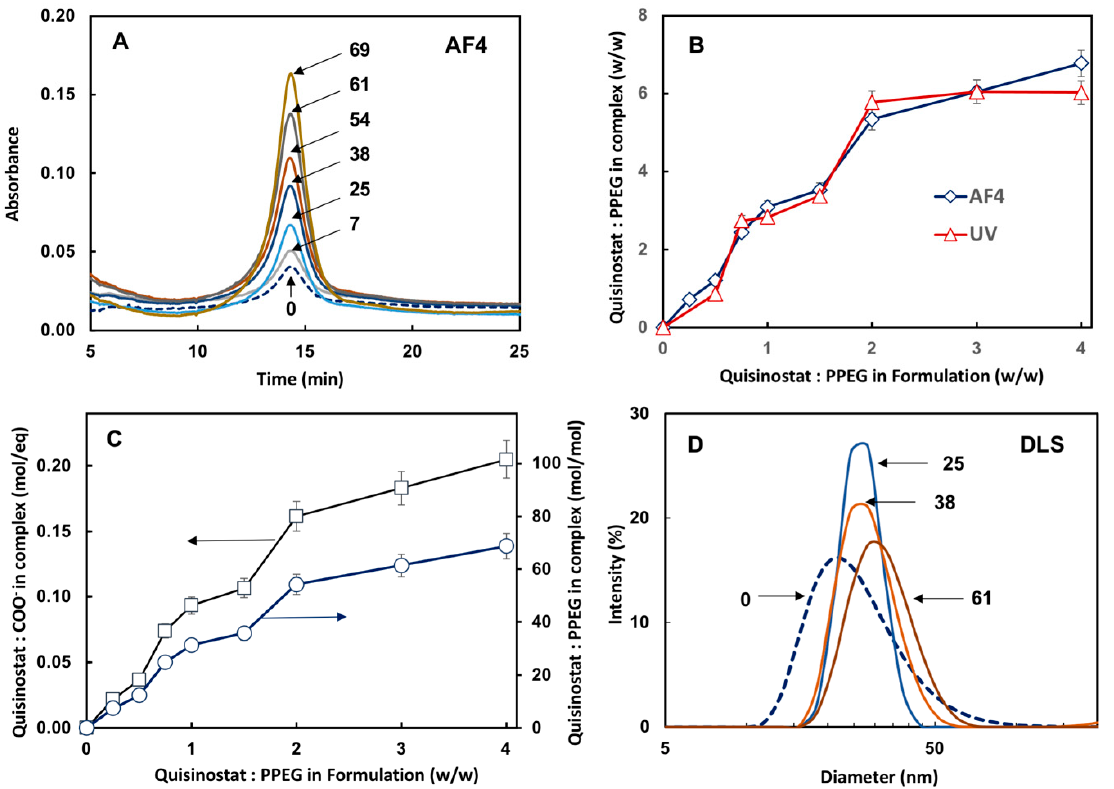
Figure 2. ( A ) AF4 fractograms of PPEG and quisinostat-PPEG complexes showing growing macromolecular peak area as the content of drug increases; ( B ) comparison of polymer composition as measured by AF4 and UV-spectroscopy; ( C ) composition of complex expressed as degree of neutralization of anionic group on PEPG and drug-to-polymer molar ratio as a function of quisinostat-to-PPEG ratio in the original formulation; ( D ) DLS profiles of quisinostat-PPEG complexes (numbers in panels ( A , D ) indicate quisinostat-to-PPEG molar ratio in the complex).